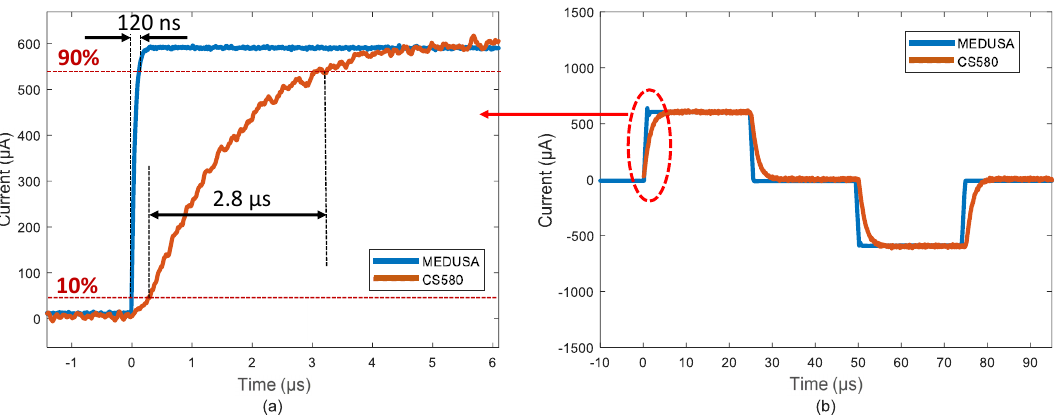
Figure 11. The rise time for the MEDUS system and SRS CS580 is 120 ns and 2.8 µ s, respectively ( a ), measured across a 1 k Ω resistive load from 10% to 90% of voltage, ( b ) and the 10 kHz